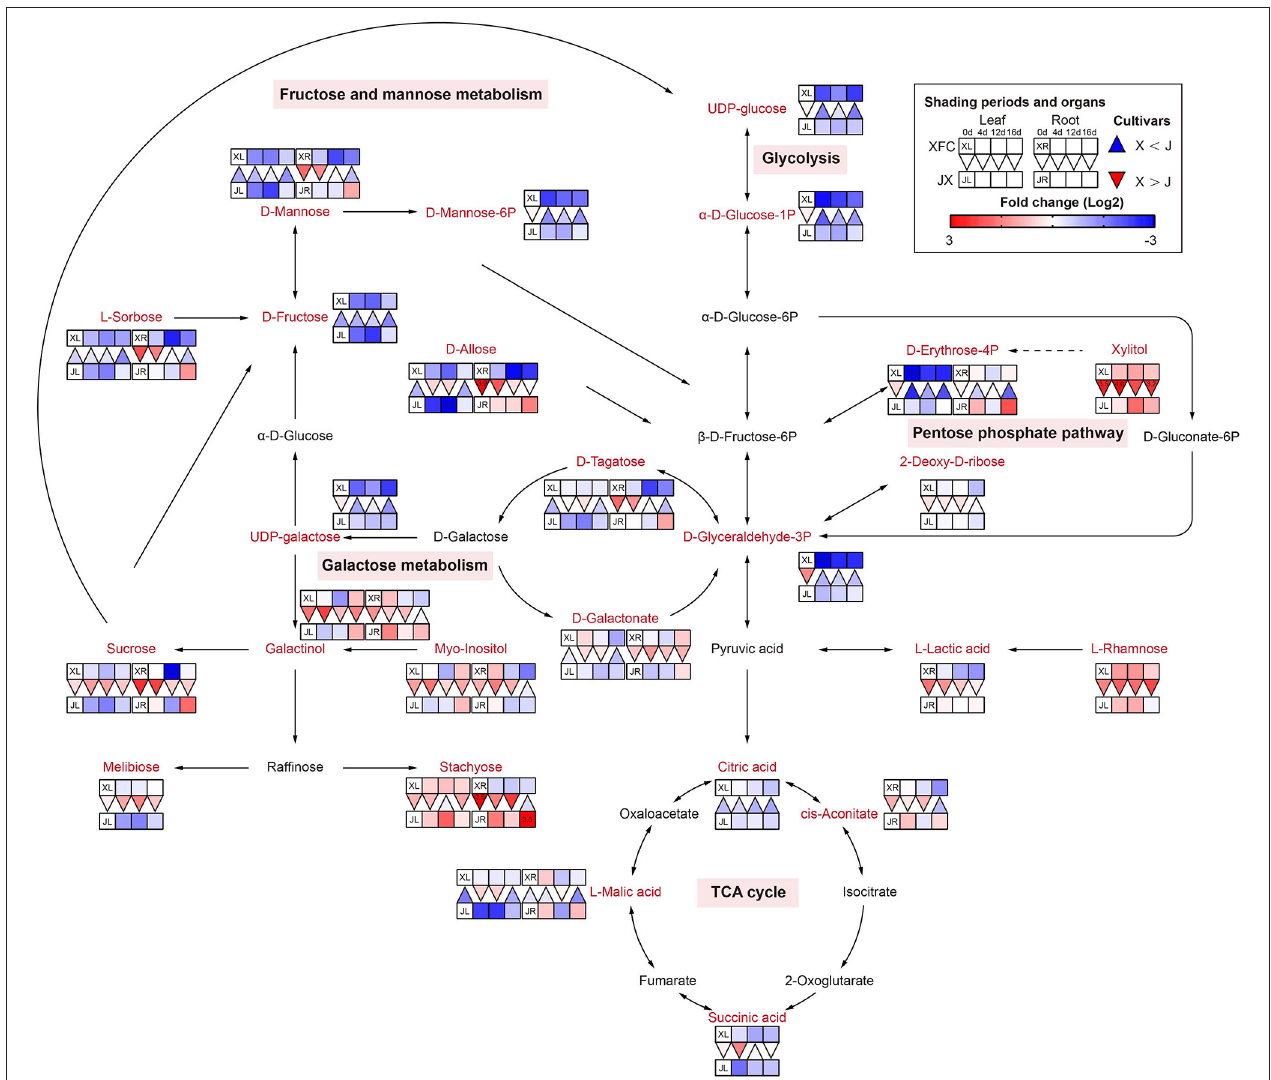
FIGURE 7 | The metabolite differences during sugar metabolism in the two tea cultivars under different shading periods. The identified metabolites are marked with a red color. In the legend, the squares at two lines express the different cultivars, “Xiangfeicui” (XFC) and “Jinxuan” (JX). The squares at eight columns express the different shading periods. The squares in the left part represent the leaves and the right part represents the roots. Blue indicates relatively low and red indicates relatively high intensity. The red triangle indicates relatively higher intensity of metabolites in XFC (X) than in JX (J), and the inverted blue triangle indicates relatively lower intensity of metabolites in XFC (X) than in JX (J). The degree of change was described with the depth of color, and the depth of the colors is based on the log2-fold change value between the samples. XL, leaf of “Xiangfeicui”; XR, root of “Xiangfeicui”; JL, leaf of “Jinxuan”; JR, root of